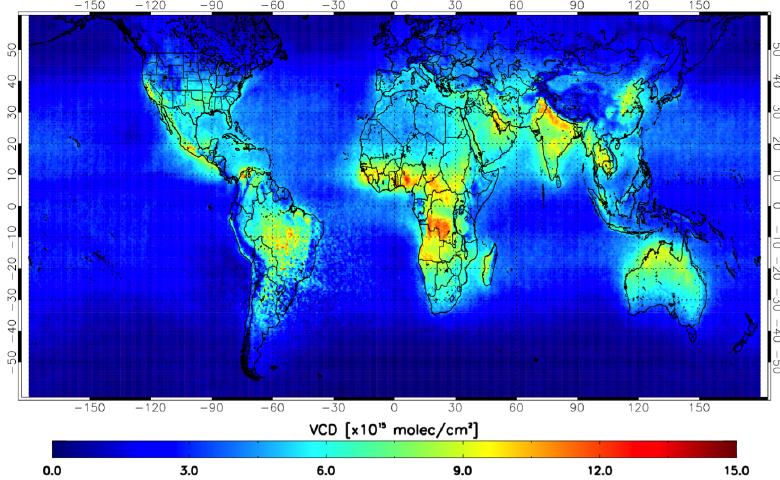
Figure 10. Averaged tropospheric HCHO columns for 2013 as measured by